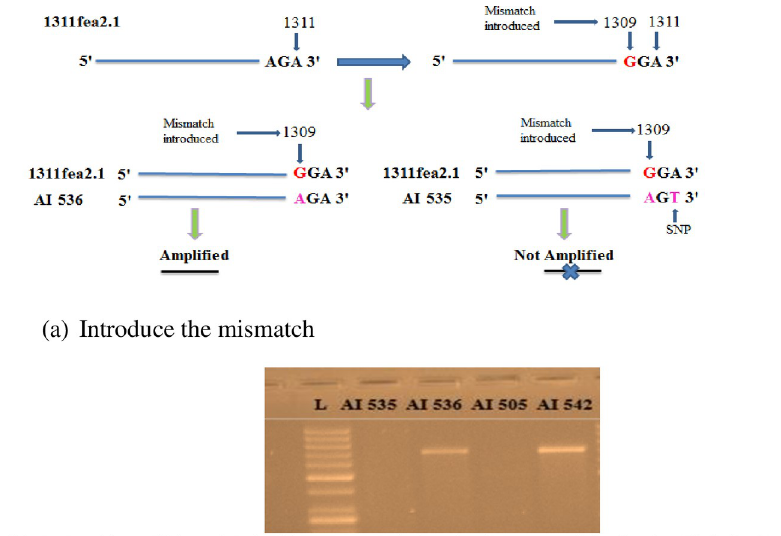
inbreds (Not amplified), AI 536 & AI 542: High KRN inbred